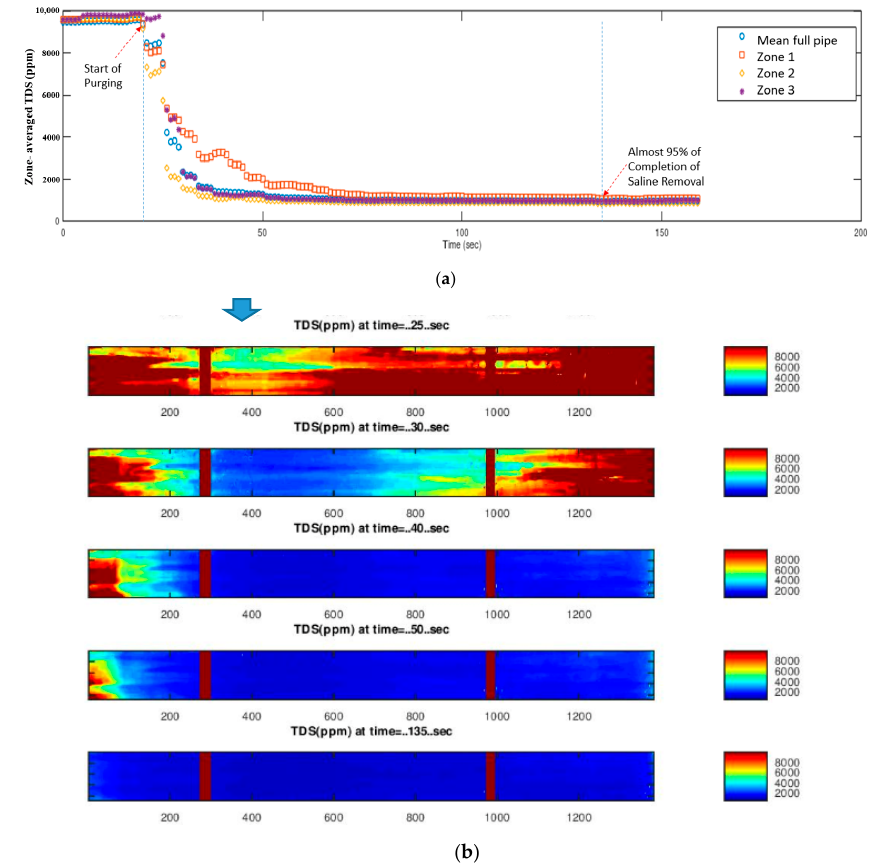
Figure 5. ( a ) Temporal Reduction of TDS (Run#12, Xp/D = 3) and ( b ) Color maps for TDS variation with the course of time (Run #12, Xp/D = 3).